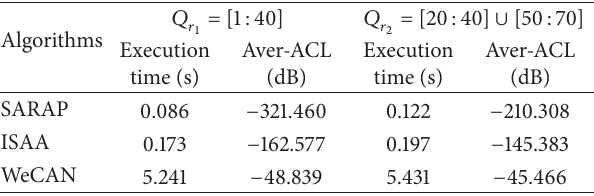
performance metric, that is, autocorrelation level (ACL), is given by